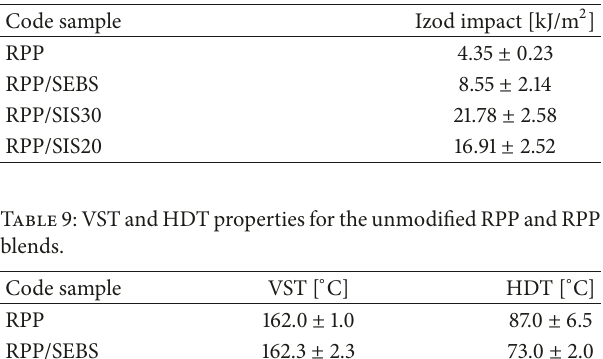
Table 8: IZOD impact strength of RPP blends.